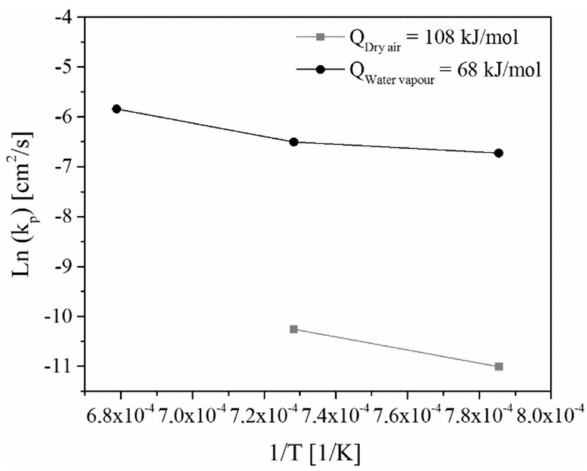
Figure 14. Arrhenius plot for the activation energy determination of parabolic oxidation ( k p ) under dry air and water vapor conditions as a function of temperature.